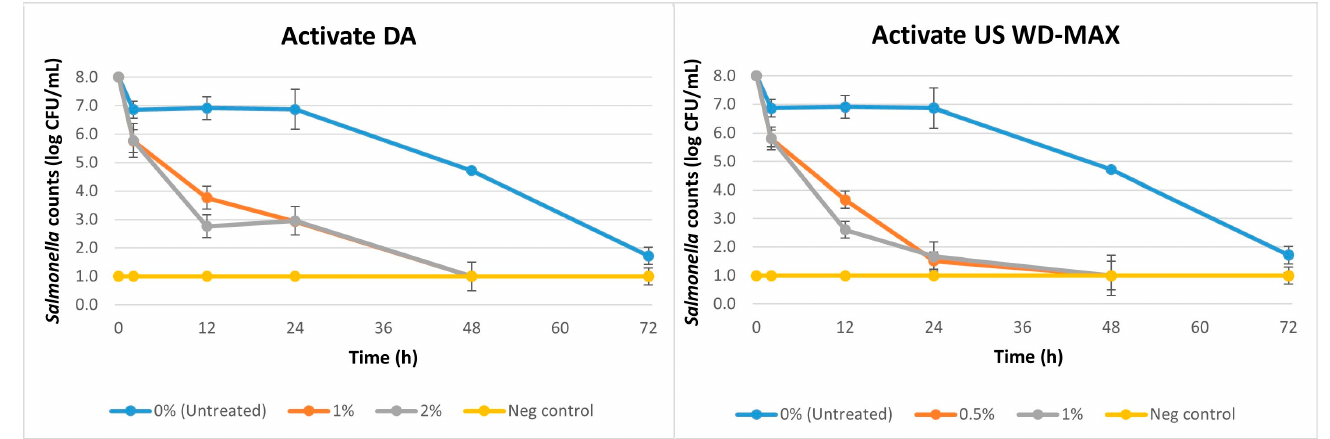
Figure 2. Mean logarithmic counts (log CFU/mL) of Salmonella in pet food kibble treatments with inclusion of organic acid mixtures Activate DA at 1% and 2% and Activate US WD-MAX at 0.5% and 1% concentrations as coating in comparison with untreated (0% organic acid). Furthermore, 0 h denotes initial load of Salmonella in inoculum before inoculation to the kibble. Salmonella counts at day 30 and day 60 are 1 log CFU/mL (not shown). A negative control consisted of canola oil-coated